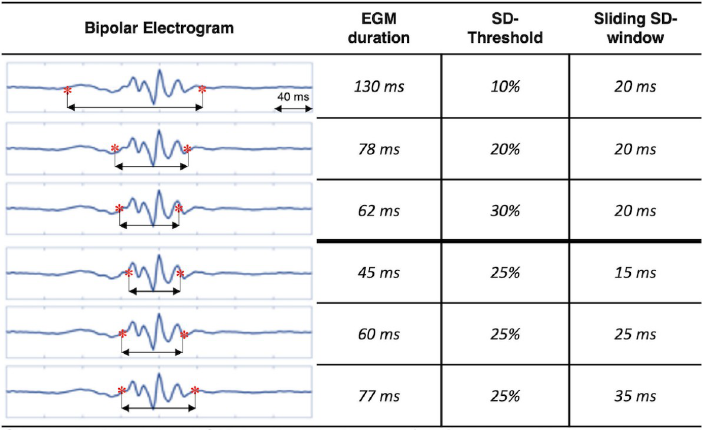
Fig 3. Visualization of Effects on electrogram duration estimation using various sliding SD-window and SD- threshold during sinus rhythm. Estimation of electrogram (EGM) duration decreases with rising SD-threshold: At SD-threshold = 10%, EGM duration is overestimated, whereas at SD-threshold = 30% EGM duration is underestimated by using constant SD-window size of 20 ms. Estimation of EGM duration increases with rising sliding SD-window: At sliding SD-window = 15 ms, EGM duration is underestimated, whereas at sliding SD-window = 35 ms EGM duration is overestimated by using constant SD-threshold of 25%.